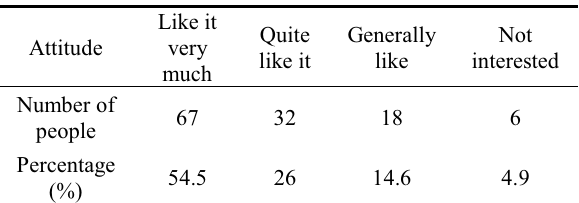
Table 6 People's attitude towards dragon boat race in